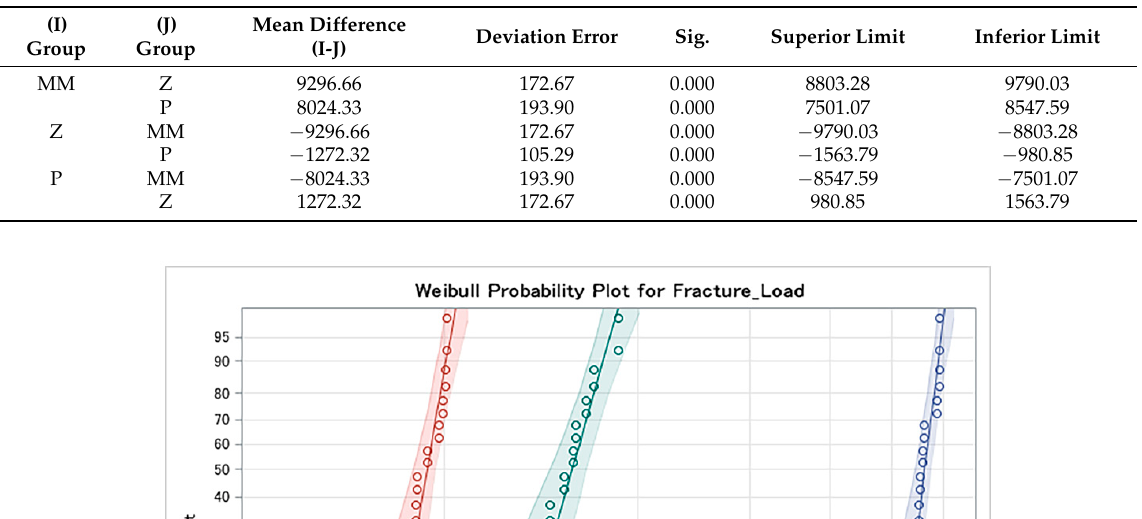
Table 2. Tamhane post hoc test. (MM: milled metal; Z: zirconia; P: PEEK).